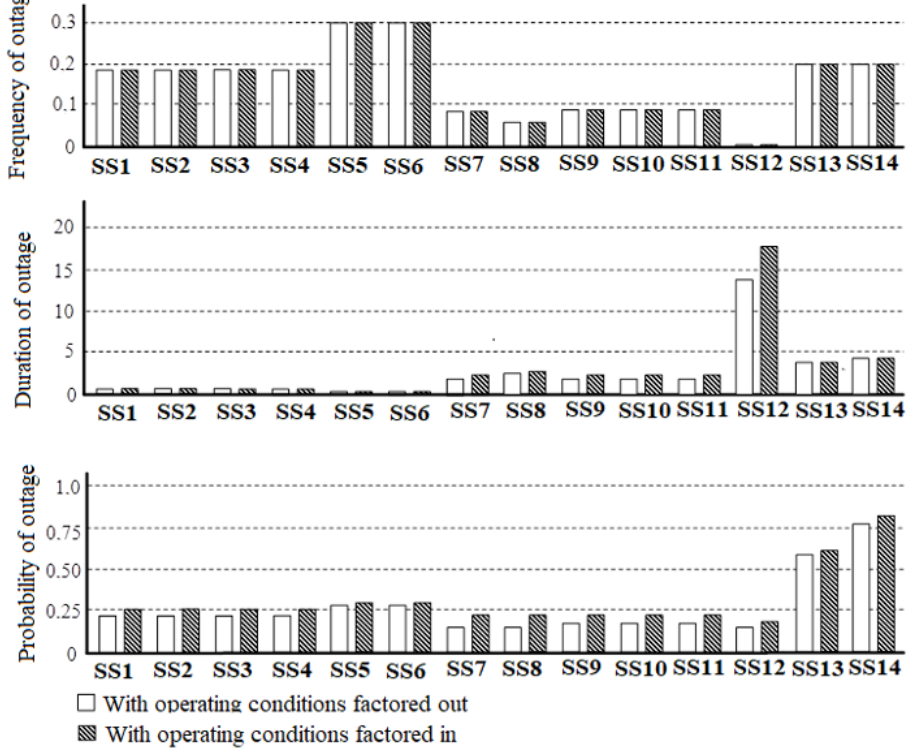
Figure 8. Reliability metrics for Structure 2 of the distribution network.